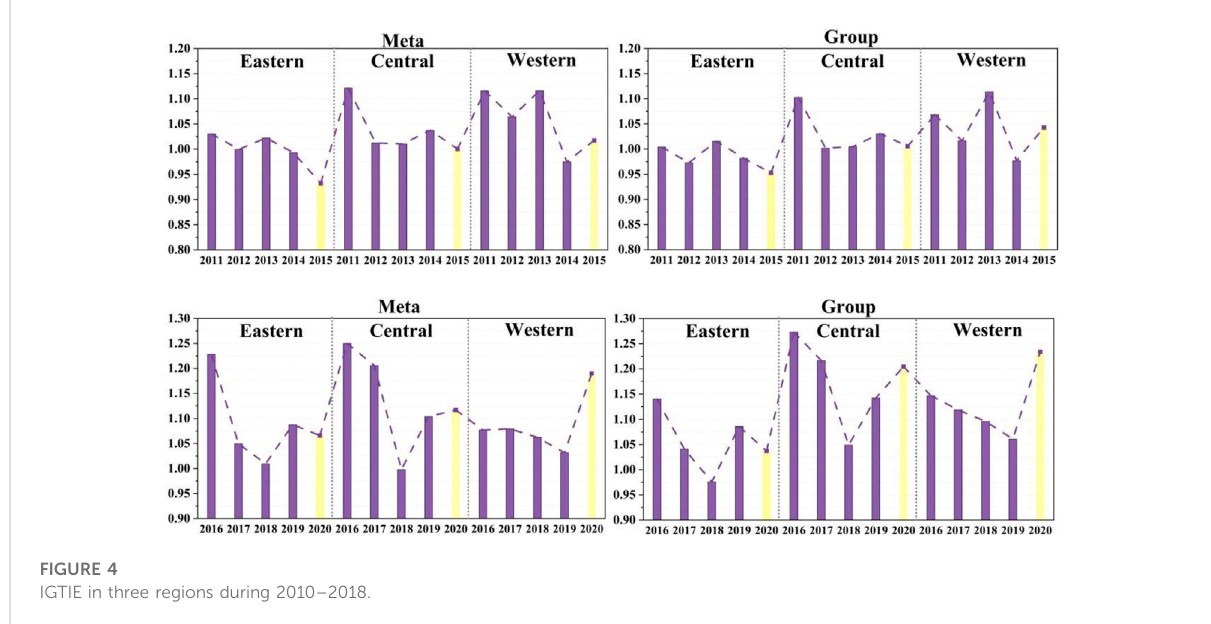
FIGURE 4 IGTIE in three regions during 2010 – 2018.